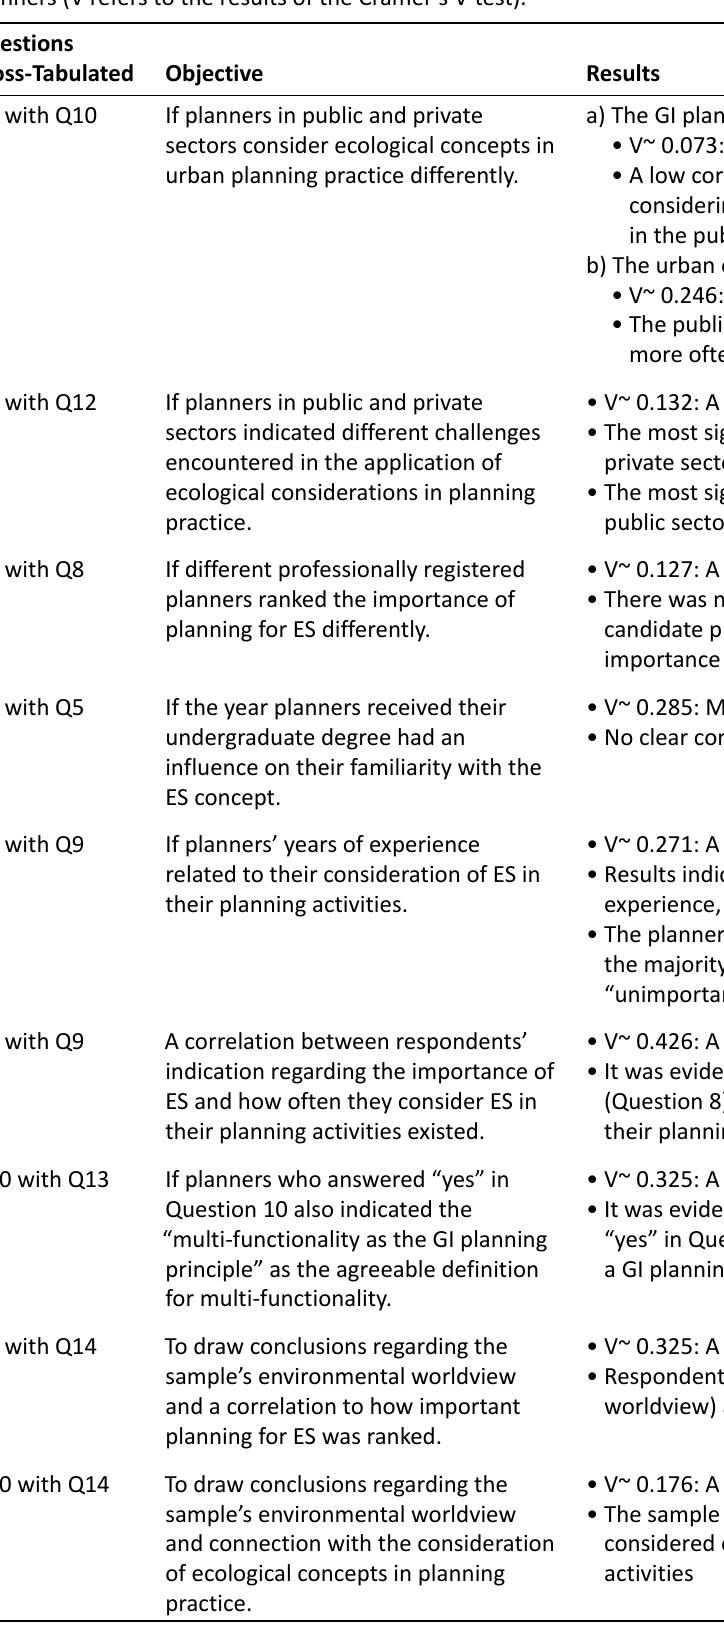
Table 3. Cross‐tabulations between selected questions of the online‐questionnaire to the sample of South African urban planners (V refers to the results of the Cramer’s